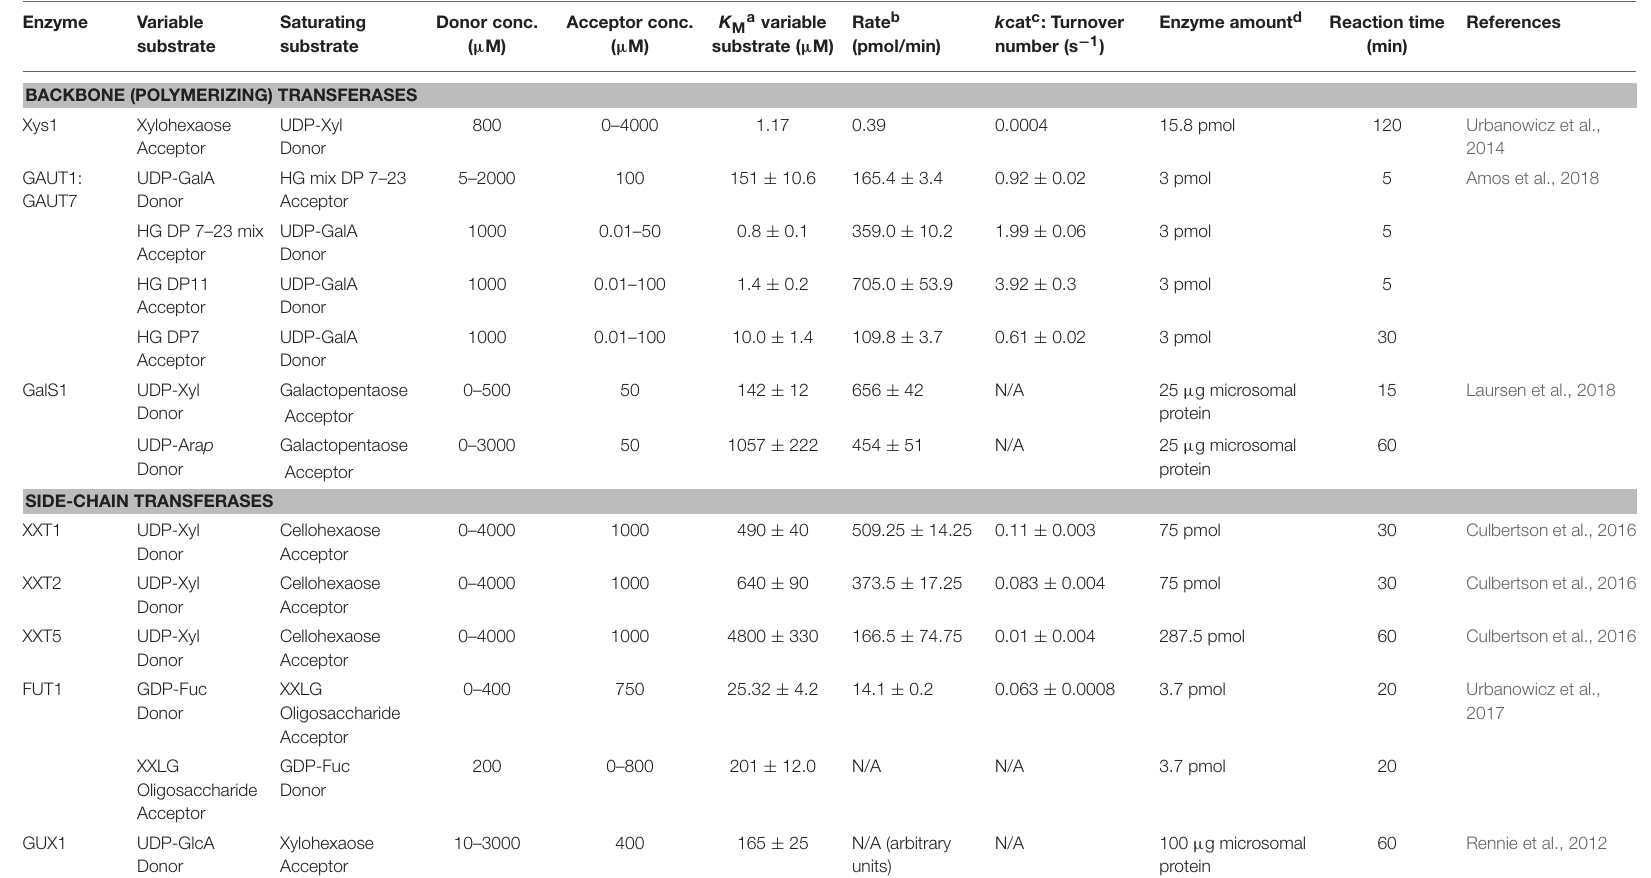
TABLE 8 | Enzymatic rates and reaction kinetics of plant cell wall polysaccharides synthesized in vitro .